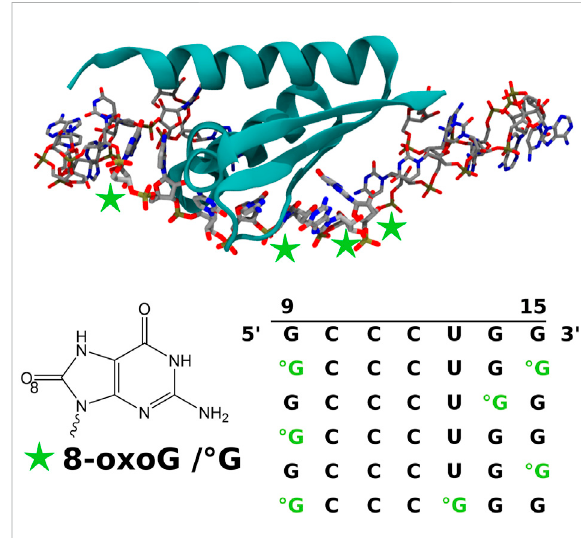
FIGURE 1 Representation of the KH 1 domain of the PCBP1 protein in theinteractionwiththe24-nucleobaseRNAstrandsobtainedafter RNAsequencemodi fi cationofthe3VKEPDBstructure(Yogaetal., 2012). The considered positions of the 8-oxoguanine (8- oxoG/ ° G) lesion are indicated by green stars. The obtained control and modi fi ed sequences for the nucleobases of positions 9 to 15 are also given. All biomolecule pictures have been rendered using VMD (Humphrey et al.,